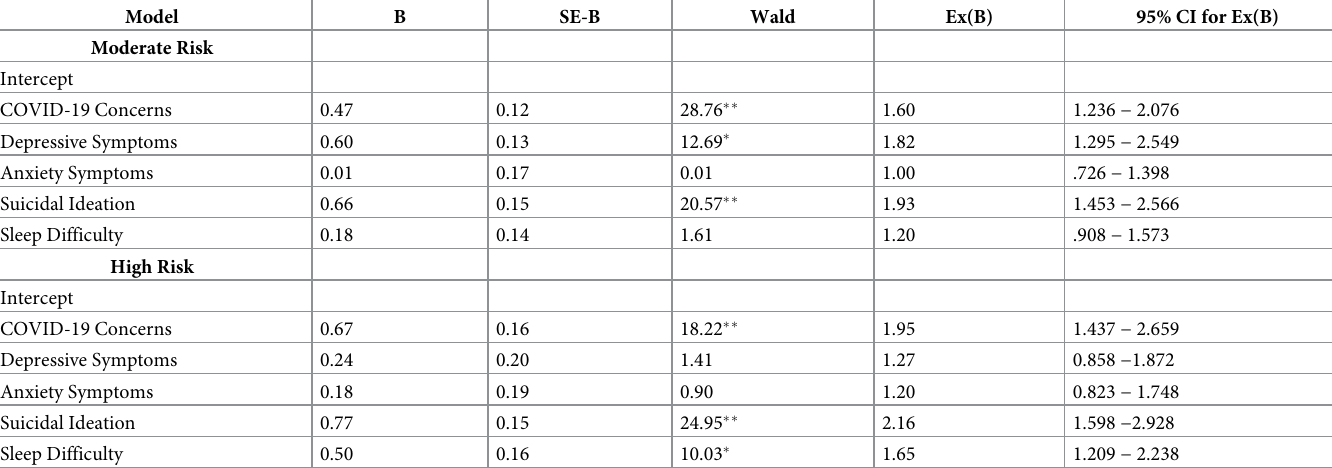
Table 5. Parameter estimates contrasting the no/low risk psychosis group versus moderate and high risk groups (n = 516).